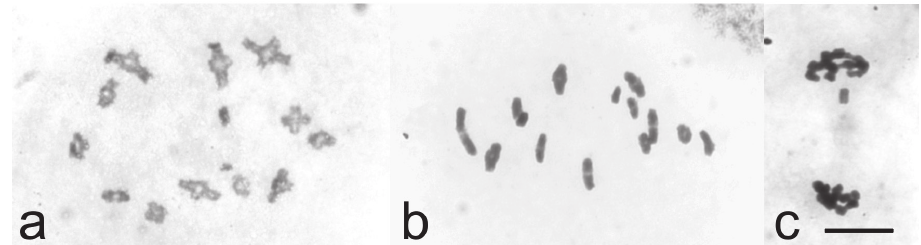
Figure 1. Chiasmate male meiosis in C. myrtilli ( a ) diakinesis with twelve autosomal bivalents an uni- valent X chromosome ( b ) metaphase I with twelve chiasmate bivalents and univalent X ( c ) telophase I, univalent X chromosome moving towards upper pole. Bar equals 10 µm.